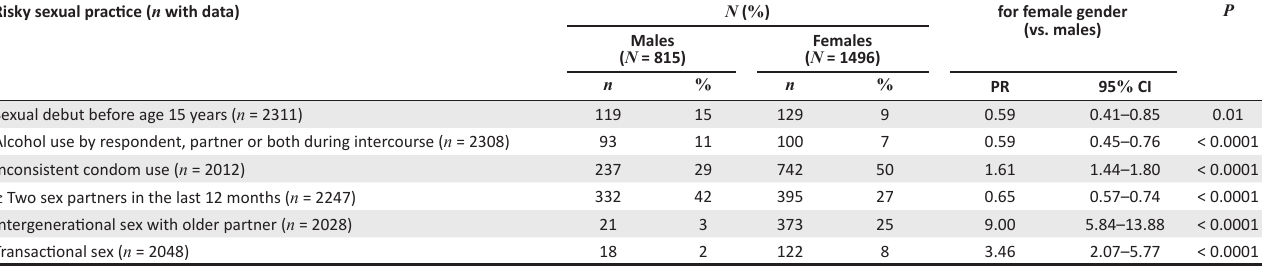
TABLE 2: Summary of risky sexual practices among sexually active adolescents and young adults by gender. Risky sexual practice ( n with data)